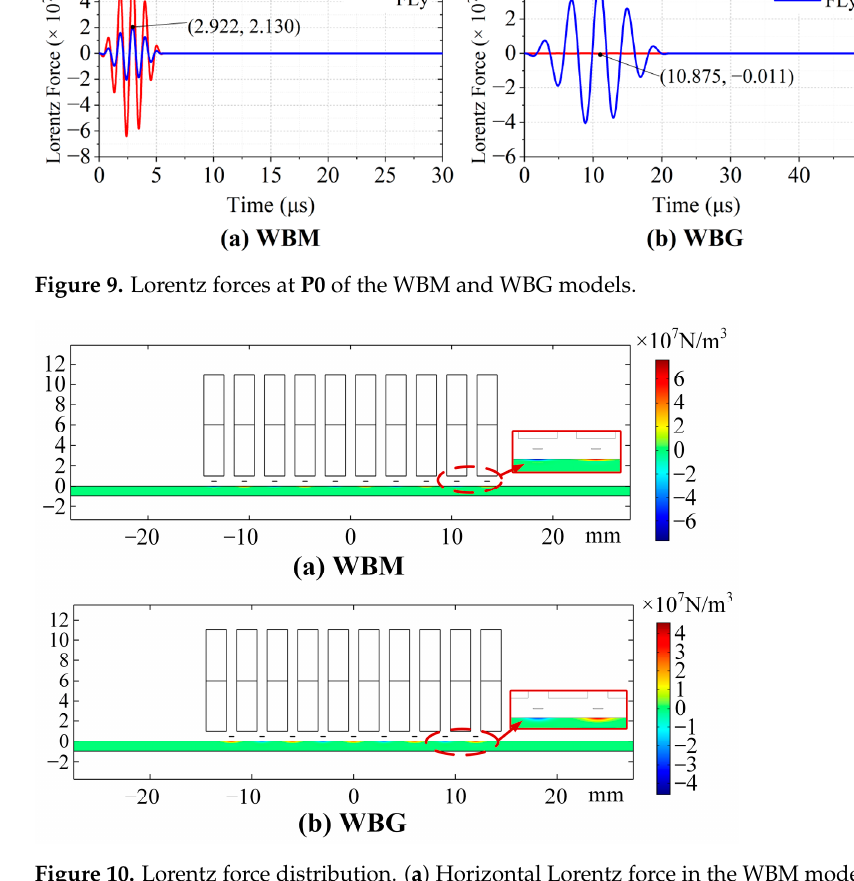
Figure 12. Displacement distribution of the WBM and WBG models at 36 μ s. Figure 13. Normalized displacement on the line at x = 60 mm along the plate thickness in ( a ) the WBM model at 14.5 μ s and ( b ) the WBG model at 32.5 μ s. Furthermore, the mode of the wave is verified by the wave velocity. Figure 14 shows the total displacements at P1 and P2 . The distance between P1 and P2 is 40 mm. In Figure 14a,b, the simulated velocity is 5333 m/s and 2526 m/s, close to the theoretical group ve- locity of S0 (5400 m/s) and A0 (2448 m/s) mode, respectively. This indicates that the WBM model mainly excites S0 mode Lamb waves, and the WBG model mainly excites A0 mode Lamb waves in the aluminium plate.